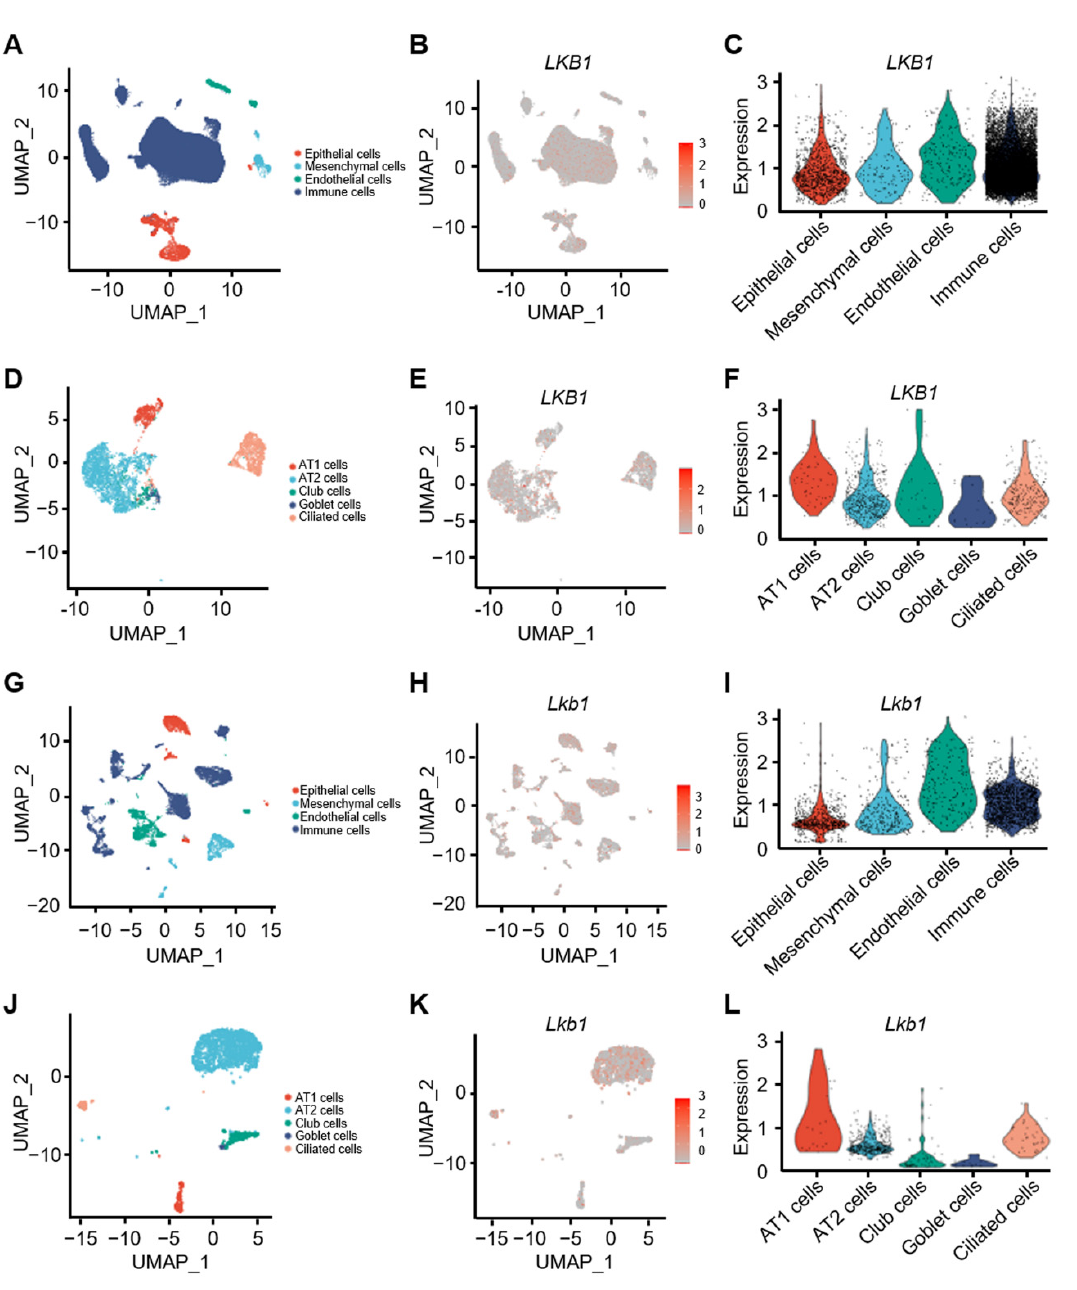
Figure 1. Distribution and expression levels of Lkb1 in human and mouse lung tissues. ( A ) Uniform manifold approximation and projection (UMAP) plots of normal human lung tissues indicate four cell types, including epithelial cells, mesenchymal cells, endothelial cells, and immune cells. ( B ) Dis- tribution of LKB1 in human lung cell types. ( C ) Violin plots of LKB1 expression levels in different lung cell types. ( D ) UMAP embedding of human lung epithelial cells. ( E ) Distribution of LKB1 expression in human lung epithelial cells. ( F ) Violin plots of LKB1 expression levels in different lung epithelial cells. ( G ) UMAP embedding of mouse lung tissue. ( H ) Distribution of Lkb1 in mouse lung cell types. ( I ) Violin plots of Lkb1 expression levels in lung cell types. ( J ) UMAP embedding of mouse lung epithelial cells. ( K ) Distribution and expression levels of Lkb1 in mouse lung epithelial cells. ( L ) Violin plots of Lkb1 expression levels in mouse lung cell types. 2.2. Lkb1 Is Required for Lung Epithelial Progenitor Cell Proliferation In Vitro As the main lung epithelial progenitor cells, club and AT2 cells are involved in the maintenance of lung epithelium function and repair after injury. Therefore, we